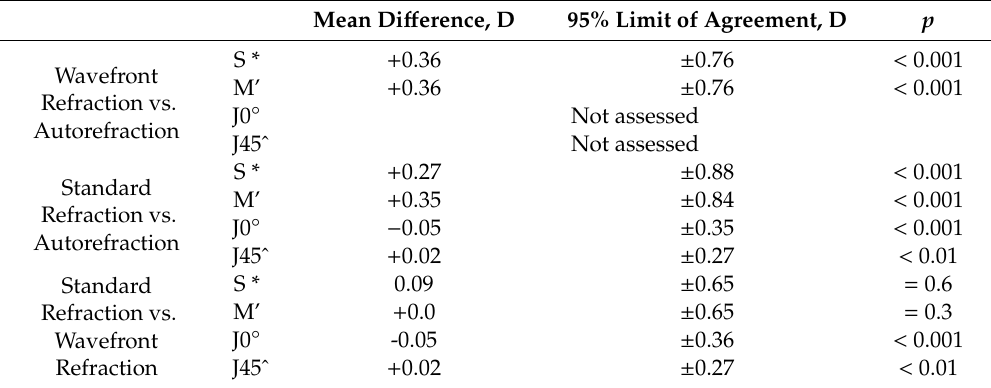
Table 1. Descriptive and statistical analysis for the comparison of the three methods to assess the habitual refractive